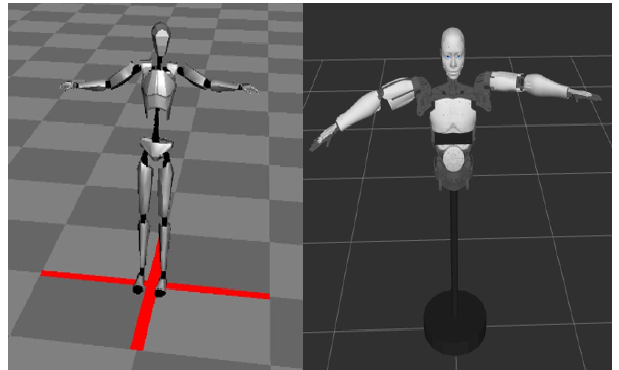
Figure 11. Different visualization terminals for different motion systems.